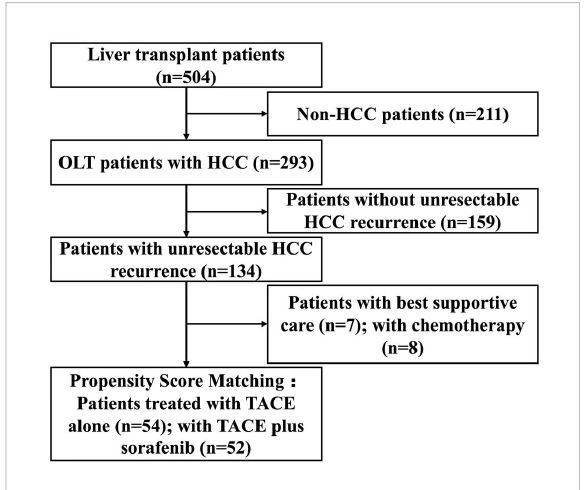
FIGURE 1 Schematic illustration of the study design and patient selection.